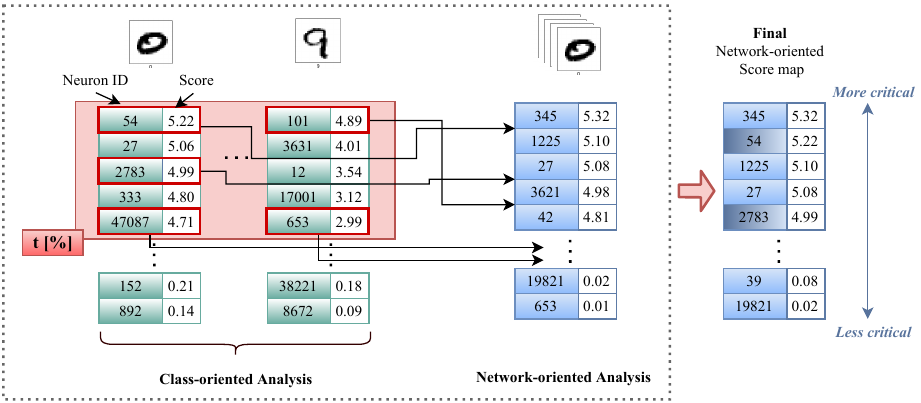
Figure 2. The critical neuron identification process: a practical example with the MNIST data